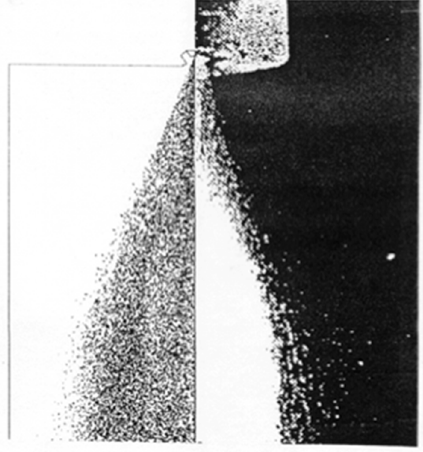
Figure 10. Qualitative comparison of spray angle with non-swirling atomizing air.